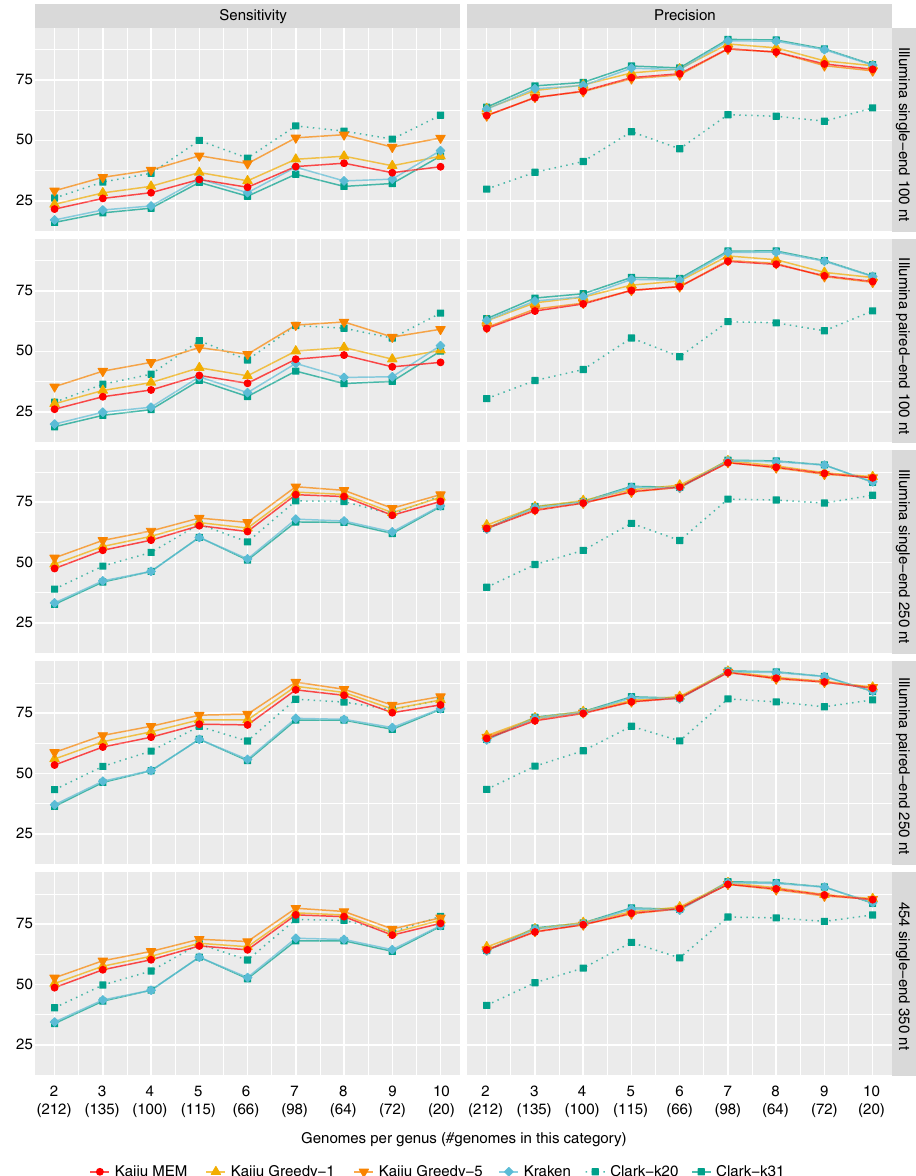
Figure 1 | Genus-level sensitivity and precision. Sensitivity and precision are shown as average for each bin of genera for the five different types of reads and the three programs. The x -axis denotes the number of genomes in the genus and the total number of genomes in that category. For example, 212 of the measured 882 genomes belong to the 106 genera with only 2 available genomes, and the data points show the mean sensitivity and precision across all 212 genomes in that category. Kaiju was run in MEM mode with length threshold m ¼ 11 a.a. and in Greedy mode with either 1 or up to 5 allowed mismatches and a score threshold s ¼ 65. Kraken uses k ¼ 31 and Clark was run with both k ¼ 31 and k ¼ 20, which is denoted by the dotted